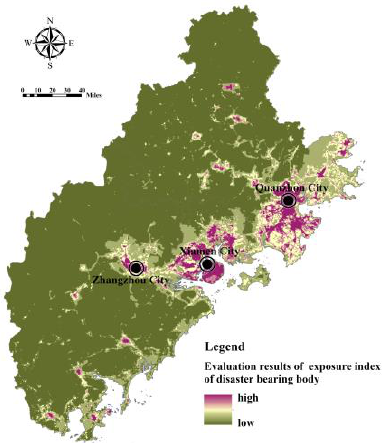
Figure 9. Assessment of the index of sensitivity of disaster-prone environments in Fujian Delta.